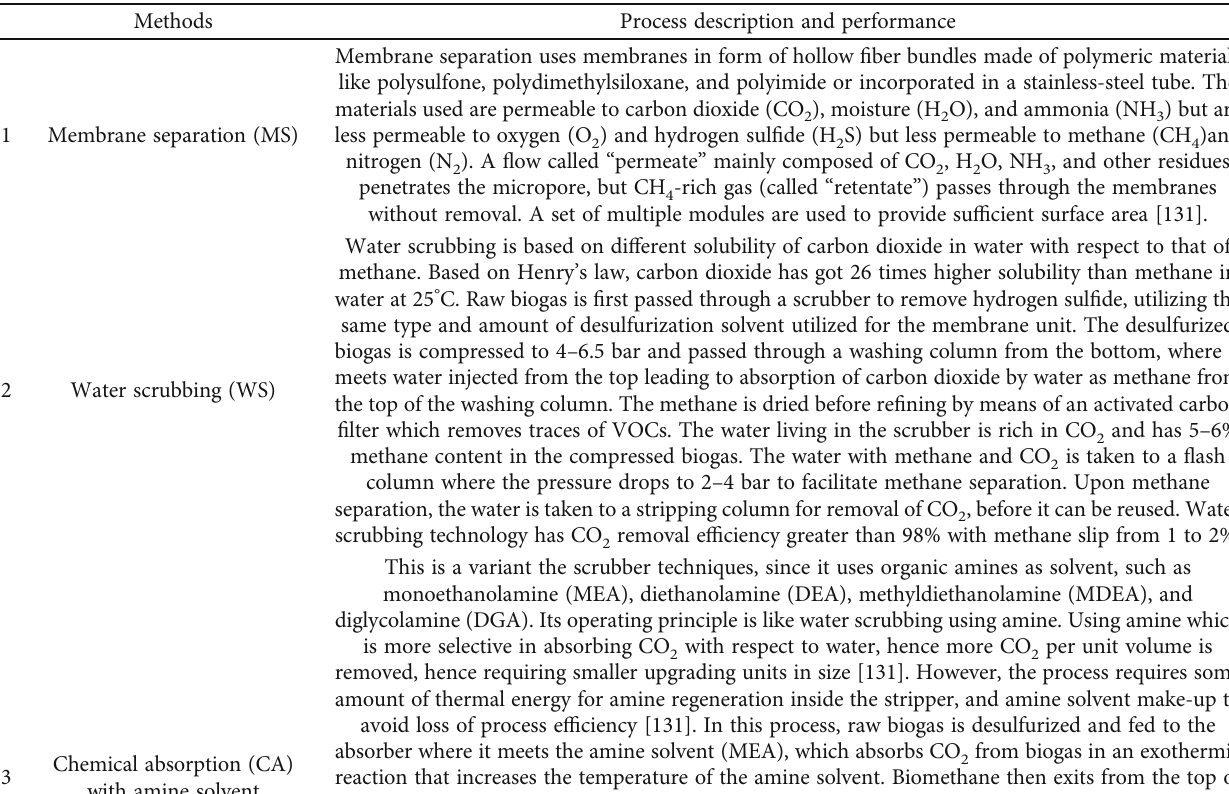
Table 9: Summary of the various methods used in biomethane